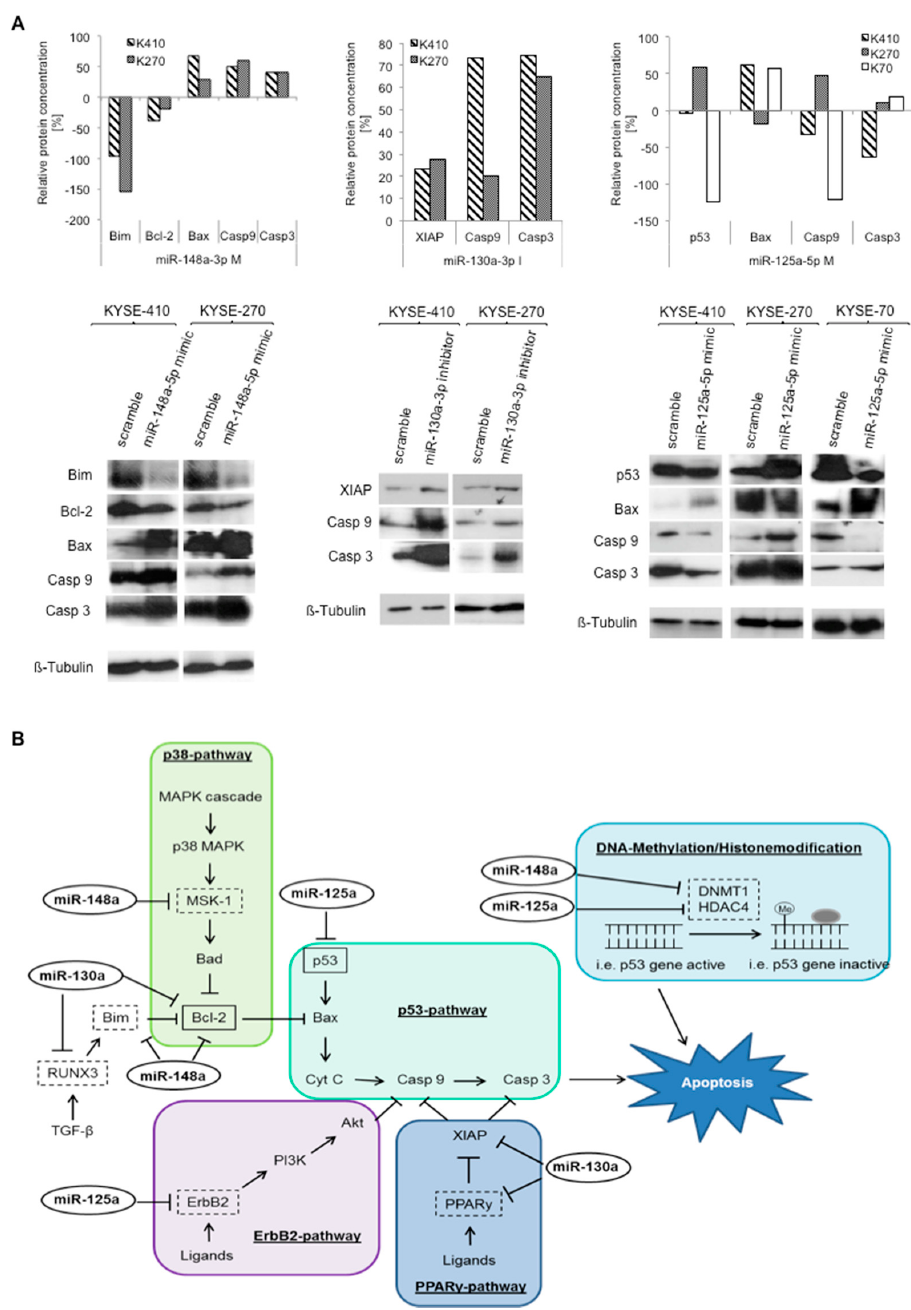
Figure 7. Specific miRNA signatures of resistant cell lines target various resistance-relevant pathways: pathway analyses. ( A ) Effect of miRNA transfection on the p53-dependant apoptosis pathway in ESCC cells. Relative protein expression levels of pathway compounds compared to controls were measured via western blot analysis; and ( B ) overview of the complex process of miRNA-mediated regulation of several resistance-relevant pathways at various key spots. Confirmed direct targets are marked in boxes with solid lines, potential targets are marked in boxes with dotted lines (adapted from Krammer et al. [20]); Bcl-2: B-cell lymphoma 2; Bax: Bcl-2-associated X protein; Casp: caspase; XIAP: X-linked inhibitor of apoptosis protein; K270: KYSE-270; K410: KYSE-410; K70: KYSE-70; M: mimic; I: inhibitor; Scr: Scramble; and *: significance ( p ≤ 0.05).